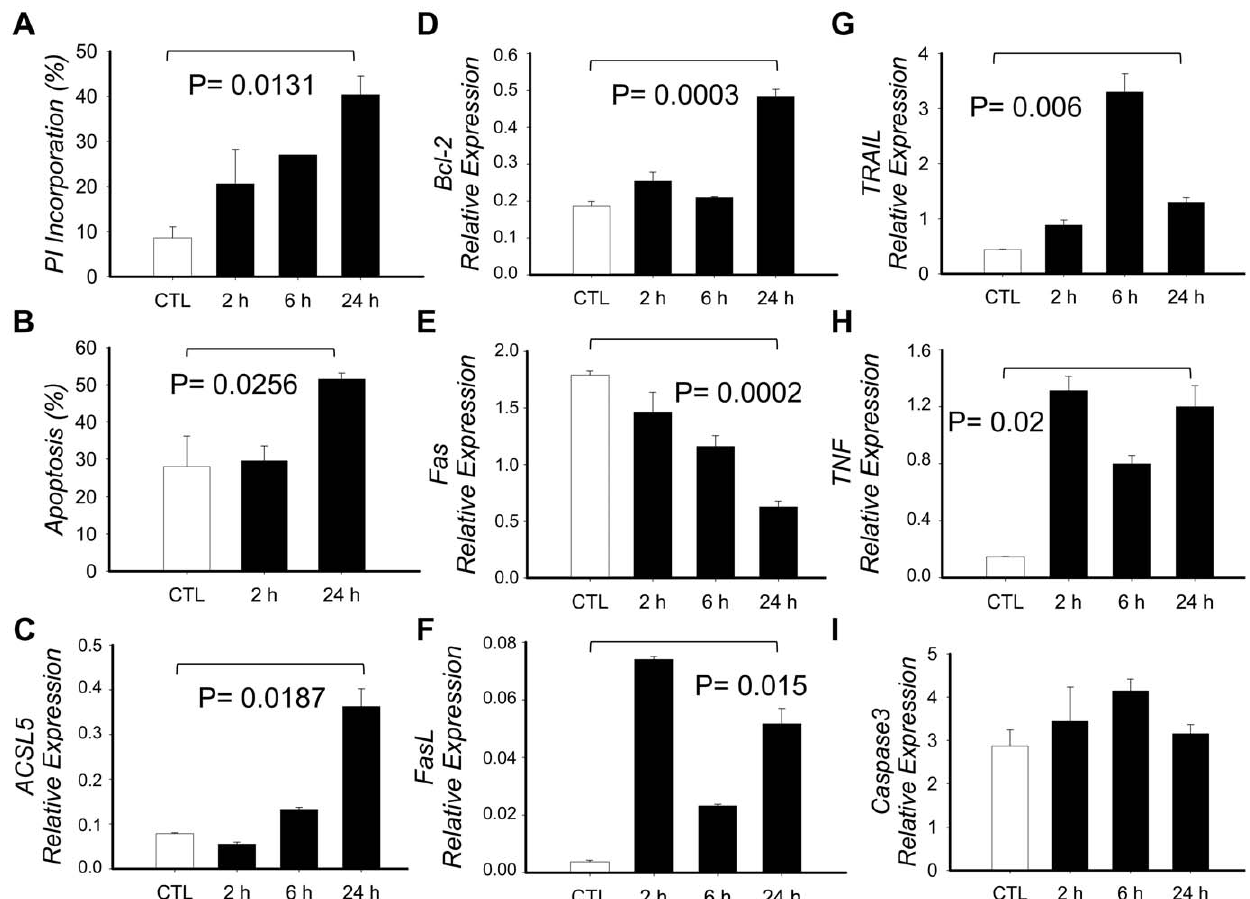
Figure 3. Effect of PMA + Io activation in Jurkat T cells. Jurkat T cells were cultured in the presence or absence of PMA + Io for up to 24 h. A) Cells were collected at defined times, washed with PBS, fixed with 70% Ethanol, stained with Propidium Iodide (PI) and analyzed in a FACSCaliburTM flow cytometer to determine the apoptotic hipodiploid cell fragments (defined as percentage of PI incorporation). B) Cells were washed twice with PBS and double stained with Annexin V and PI, then analyzed by FACS to determine the percentage of apoptotic cells (Annexin V positive and double positive cells). C–I) Total RNA was extracted, cDNA synthesized and qRT-PCR implemented to determine mRNA expression. Results are given by means of three independent experiments and the bars show the standard deviation. P-value has been calculated with the paired Student t